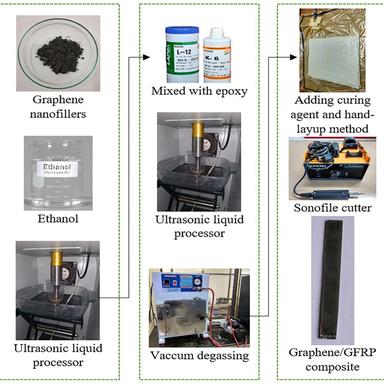
Preparation of graphene reinforced GFRP composites.